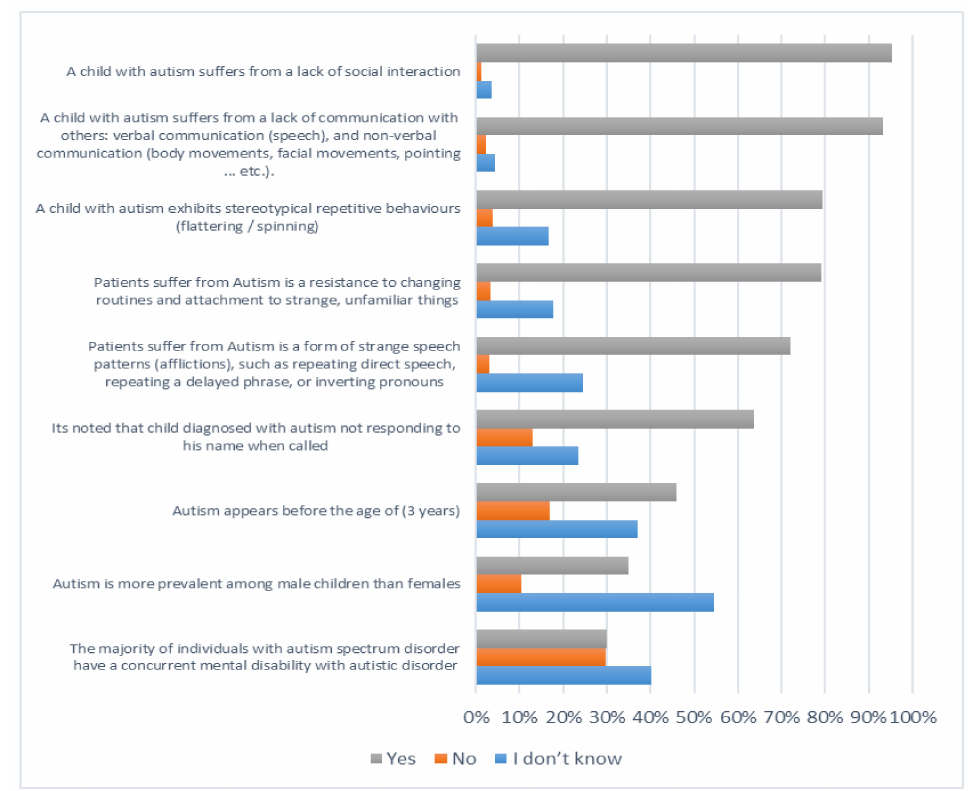
Figure 2. The level of knowledge of the characteristics of children with autism disorder.